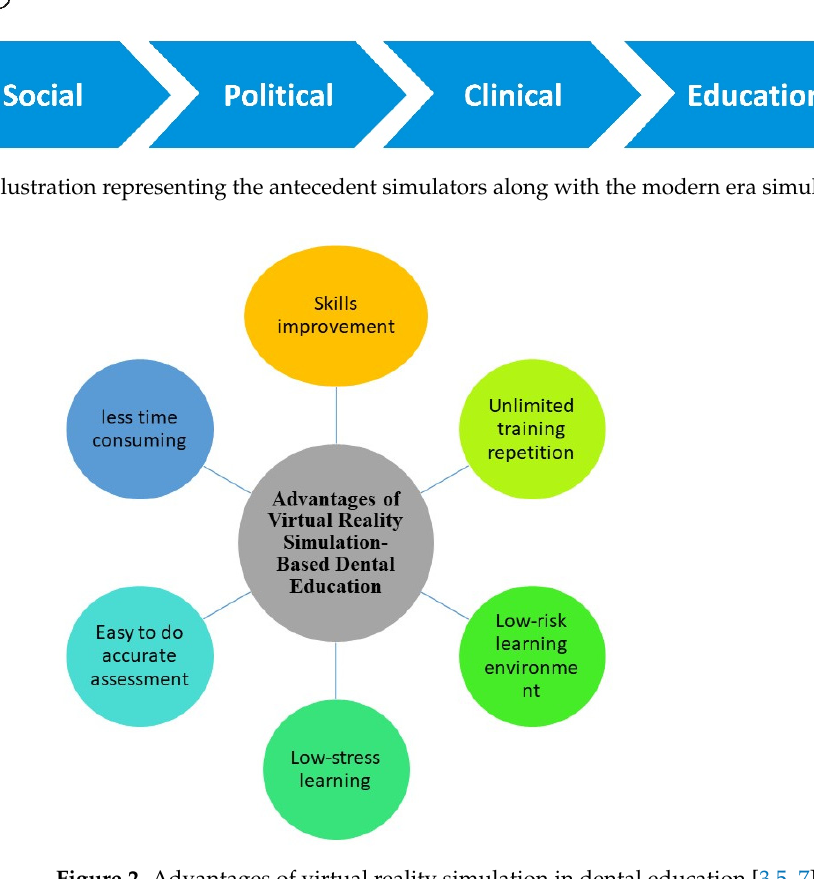
Figure 2 . Advantages of virtual reality simulation in dental education [3,5–7].